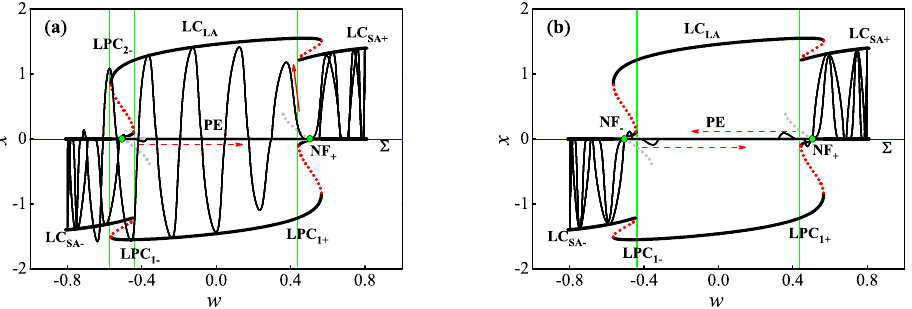
Figure 11. The slow–fast decomposition of responses when Ω = 0.027174 and Ω = 0.0285. ( a ) Asym- metrical period–1 T E MBOs when Ω = 0.027174; ( b ) symmetrical period–1 T E TBOs when Ω =